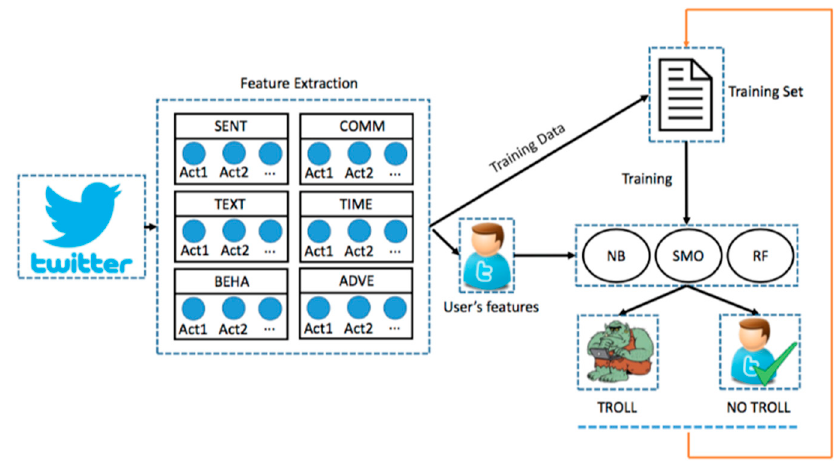
Figure 4. The TrollPacifier multi-agent system.